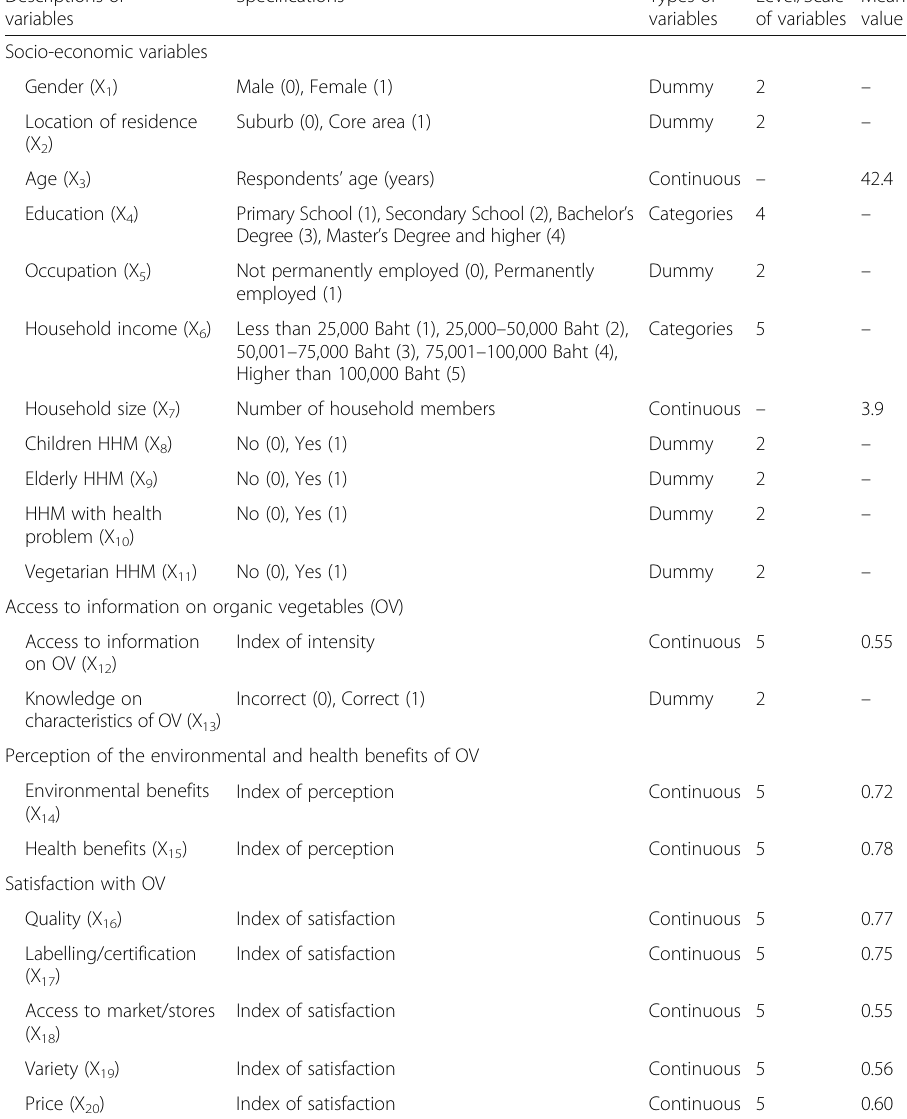
Table 2 Descriptions of independent variables included in the Stepwise Multiple Linear and Binary Logistic Regression Models ( n =